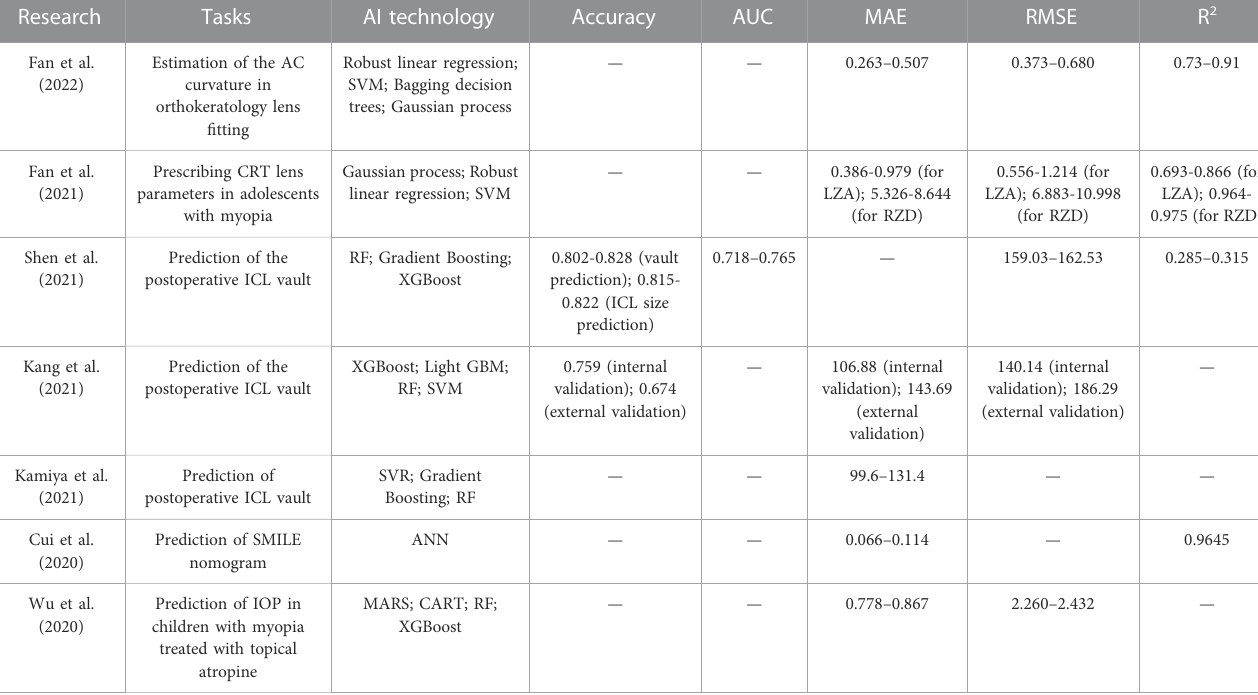
Frontiers in Cell and Developmental